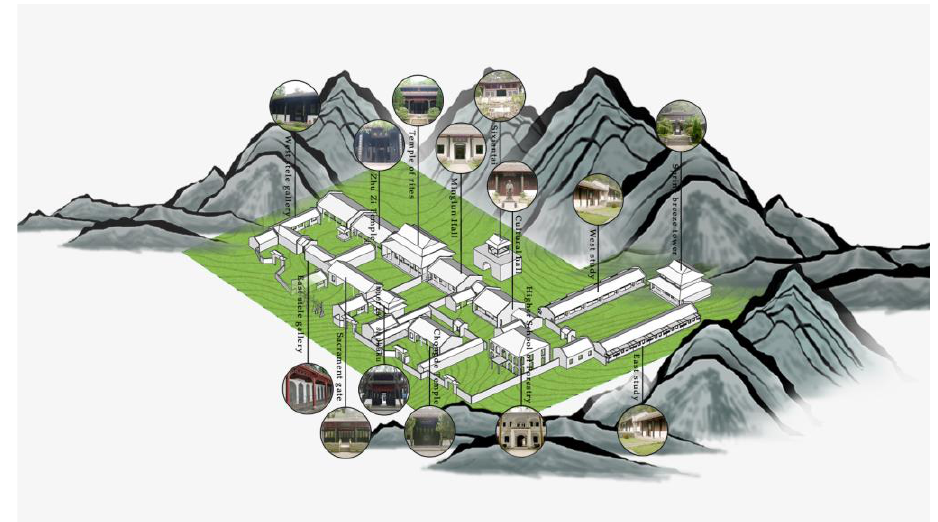
Figure 4. Layout plan of the buildings in the Bailudong Academy